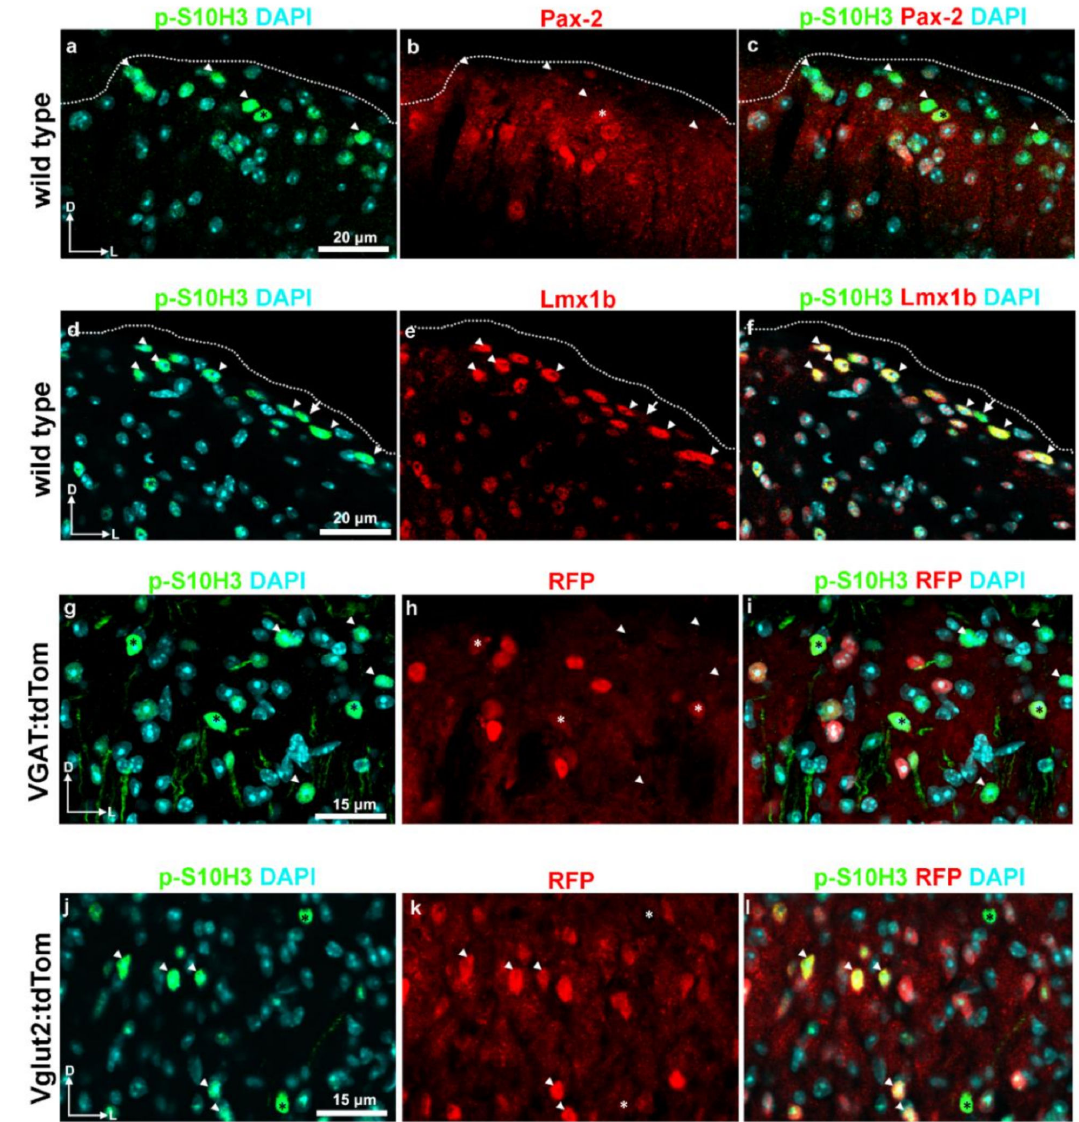
Figure 5. p-S10H3 is upregulated predominantly in excitatory interneurons both in wild-type and transgenic mice after burn injury. ( a – c ) Immunostaining with antibodies against p-S10H3 (green) and Pax-2 (red) in a transverse section of a wild-type mouse. In this field of view, there is only one Pax-2-positive neuron that exhibits p-S10H3-IR in its nucleus (asterisk). Arrowheads mark p-S10H3-IR neurons which lack Pax-2. ( d – f ) Immunostaining with antibodies against p-S10H3 (green) and Lmx1b (red) in a transverse section of a wild-type mouse. In this field of view, there are numerous p-S10H3-positive neurons co-labeled with Lmx1b (arrowheads), while there is only one p-S10H3-IR cell that lacks Lmx1b (arrow). The dotted line indicates the border between gray and white matter ( a – f ). ( g – i ) Immunostaining with antibodies against p-S10H3 (green) and red fluorescent protein (RFP) (red; against to tdTomato) in a transverse section of a vesicular gamma-amino butyric-acid (GABA) transporter (VGAT):tdTomato transgenic animal. There are three p-S10H3-positive neurons that exhibit weak RFP labeling in their cytoplasm (asterisks). Several p-S10H3-IR neurons without RFP-labeling can also be visible (arrowheads). ( j – l ) Immunostaining with antibodies against p-S10H3 (green) and RFP (red; against to tdTomato) in a transverse section of a Vglut2:tdTomato transgenic animal. Nearly half of the p-S10H3-positive nuclei are located in tdTomato-positive somata (arrowheads), indicating their glutamatergic nature. There are additionally two p-S10H3-expressing neurons that lack RFP signals (marked with asterisks). D, dorsal; L,